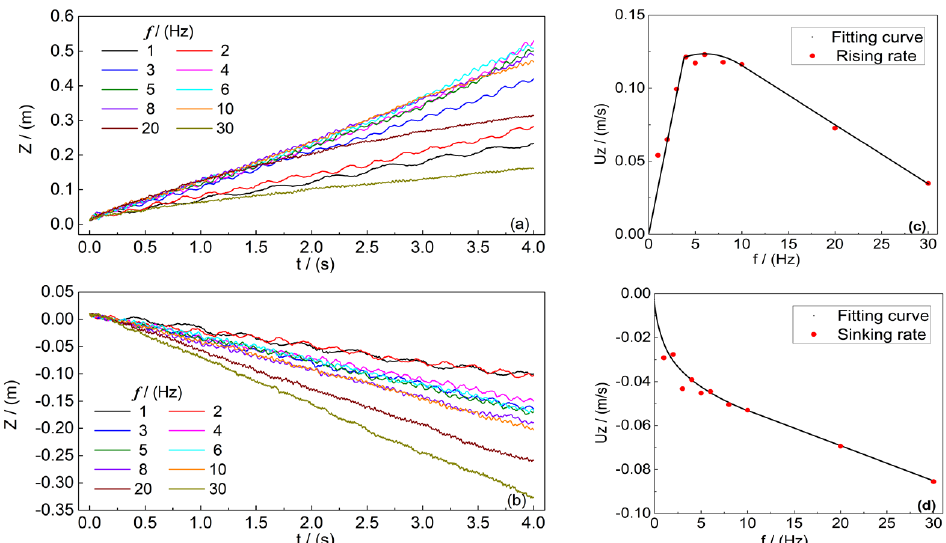
Figure 8. The displacement of the SO in the z direction as a function of the frequency f for A = 0.03 m for ( a ) Ω = − 80 rad/s and ( b ) Ω = 80 rad/s. The rising rate as a function of f at the same amplitude for ( c ) Ω = − 80 rad/s and ( d ) Ω = 80